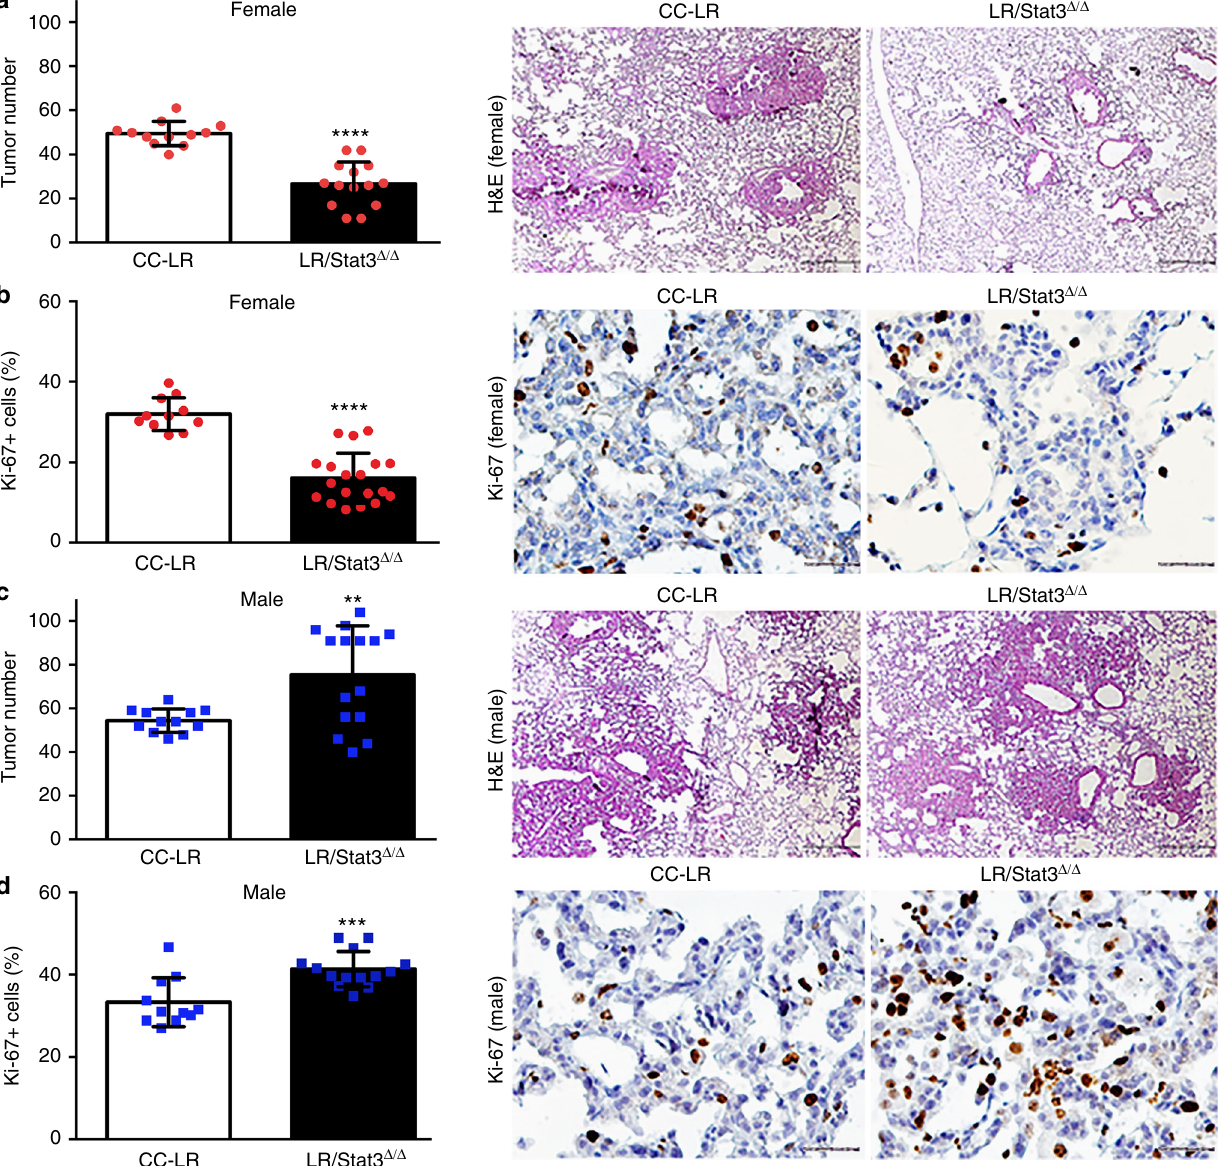
Fig. 1 Epithelial Stat3 deletion induces sex-associated differences in K-ras mutant tumor burden. Lung surface tumor number (left panel) and histopathologic appearance (40× magni fi cation, scale bar = 100 μ m) of the lung in female (red circles, n = 12 – 14) ( a ) and male (blue squares, n = 12 – 15) ( c ) CC-LR (middle panel) and LR/ Stat3 Δ / Δ (right panel) mice at the age of 14 weeks. Quantitative analysis (left panel) and representative lung photomicrographs (20× magni fi cation, scale bar = 50 μ m) of positive tumor cells for Ki-67 in female ( n = 11 – 14) ( b ) and male ( n = 12 – 14) ( d ) CC-LR (middle panel) and LR/ Stat3 Δ / Δ (right panel) mice at the age of 14 weeks. (Data represent means ± standard error of mean (SEM); **** P < 0.0001; *** P < 0.001; ** P < 0.005 using two-tailed t -test, experimental replicate # 3 –